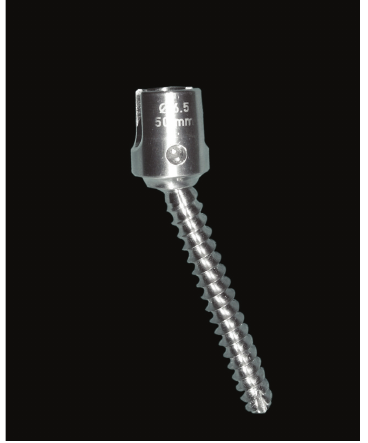
Figure 12: Saphinas